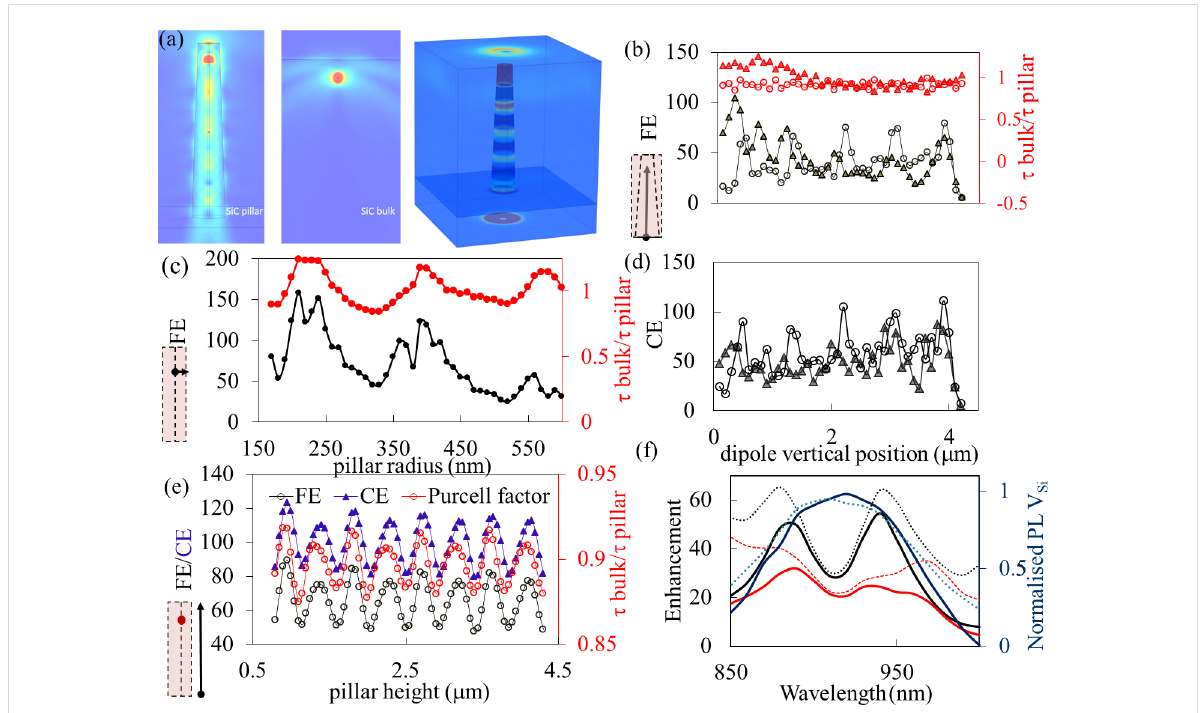
Figure 8: Finite-element method simulation for a pillar of 4.3 µm height and a dipole orientation 8° off the c -axis. Two geometries of the pillars are considered, cylindrical (circles) and conical (triangles). (a) Radiation pattern: intensity and power outflow from a conical pillar with emitters at 3.9 μ m from the bottom of a pillar, compared to an emitter 400 nm below the bulk surface. (b) FE and τ bulk / τ pillar as functions of the vertical position of the dipole for a cylindrical pillar of radius 350 nm (circles) and for the conical pillar (triangles). (c) FE and τ bulk / τ pillar as functions of the radius of a cylin- drical SiC pillar for a dipole located at 3.9 μ m from the bottom. (d) Simulated collection efficiency (CE) enhancement relative to bulk as a function of the vertical position of the dipole in a cylindrical pillar of radius 350 nm (circles) and for the conical pillar (triangles). (e) FE, CE, and Purcell factor as functions of the pillar height of the conical pillar with a fixed emitter at 450 nm from the surface. (f) FE (red lines) and CE (black lines) enhancement as functions of the wavelength for the conical pillar with an emitter located at 2.3 µm from the bottom (experimental case), showing the effect of the broad emission of V Si on FE and CE. The FE reduction across the spectra is ca. 24% compared to a narrow emission. Dashed lines represent the calcu- lated enhancements, and the solid lines represent the enhancement modulated by the emission spectra of V Si , which is also shown as a dashed blue line in the bulk and solid blue line in the